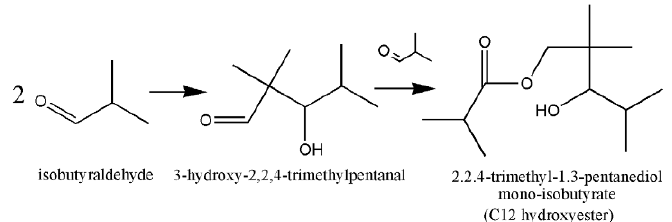
Figure 1. Condensation of isobutyraldehyde to obtain 2,2,4-trimethyl-1,3-pentanediol mono-isobutyrate (C12 hydroxyester).